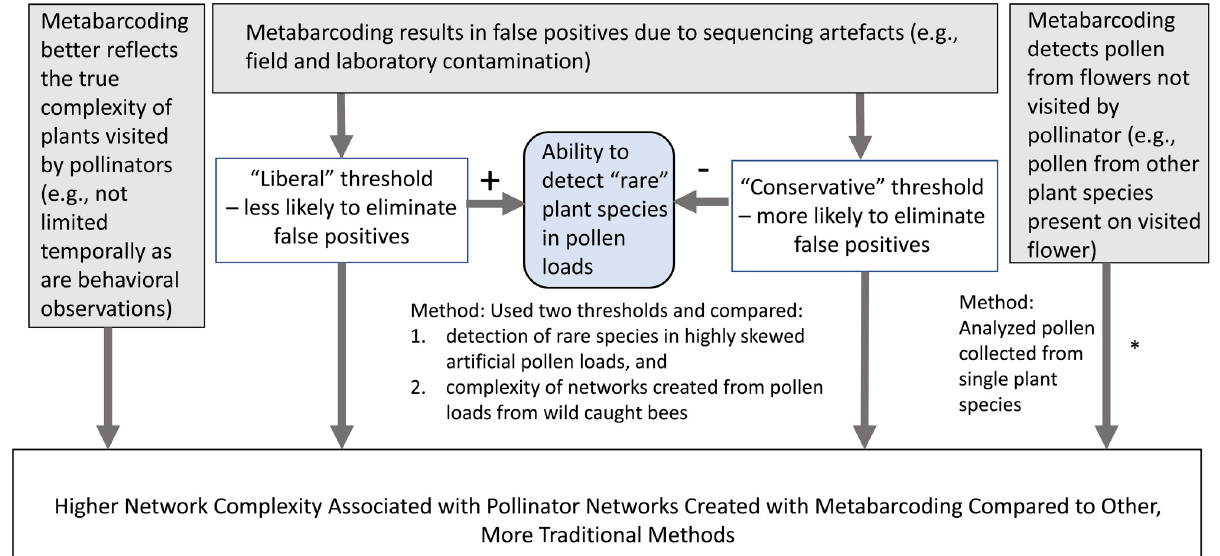
Fig 1. Three general explanations for greater complexity associated with pollinator networks derived from metabarcoding. Three general explanations for the pattern of higher complexity often associated with pollinator networks based on metabarcoding data compared to more traditional methods. Possible explanations are shown in gray boxes. Explanations are not mutually exclusive. The potential impacts of “liberal” and “conservative” thresholds (employed to decrease false positives) on the ability to detect rare species (shown in the blue rounded box) are depicted with signed arrows. “Rare” plant species in the network are those that may be visited by only a few individuals of a particular pollinator species, or may be visited by many species, but at relatively lower rates compared to other plant species. * This process is also influenced by threshold selection, but is not shown to simplify the